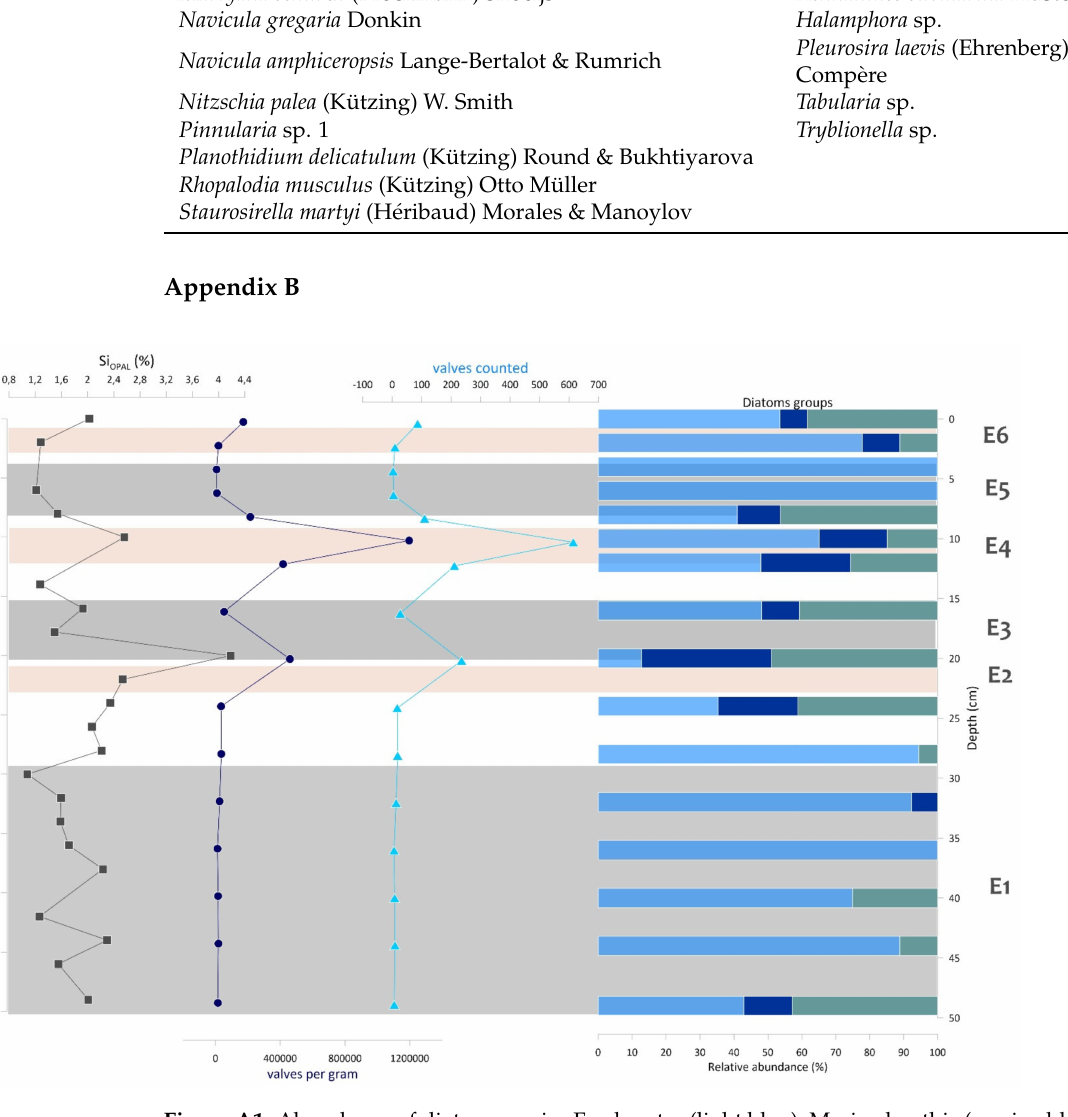
Figure A1. Abundance of diatom species Freshwater (light blue), Marine benthic (marine blue), and Brackish (green) in the different marine (grey) and continental (brown)